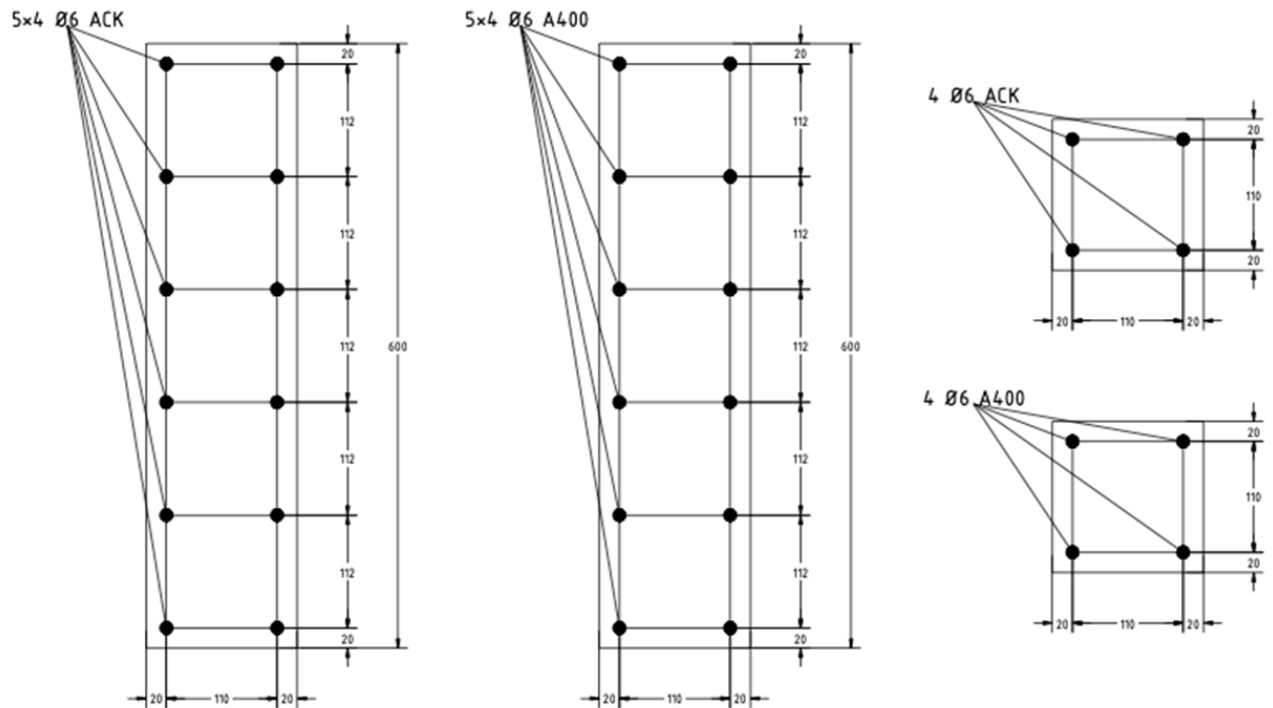
Figure 1. Scheme of the reinforcement of prototypes.